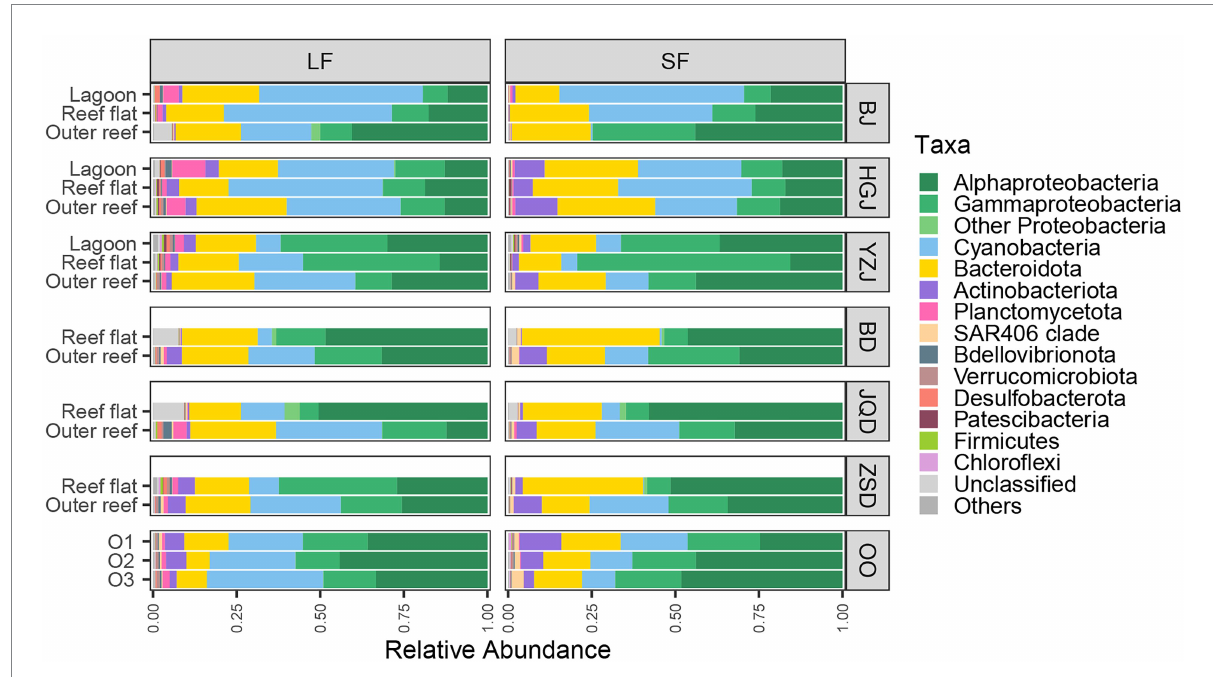
FIGURE 3 Community composition of bacterial groups that are specific to a given number of samples.